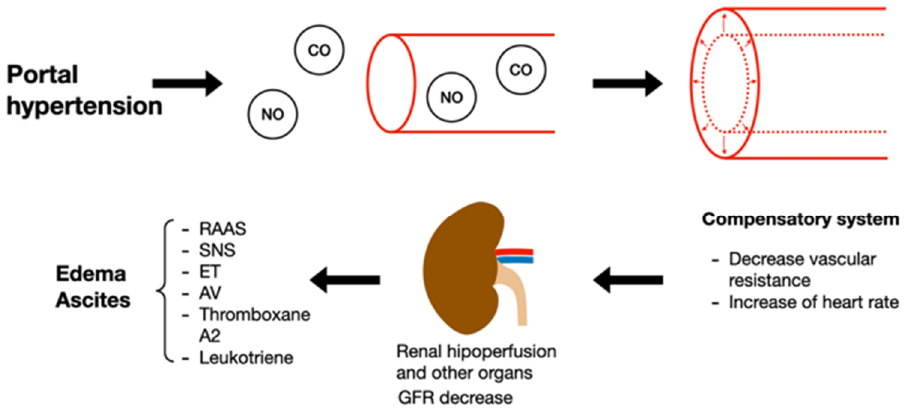
Figure 4. Pathophysiology of kidney damage induced by liver disorders. NO: nitric oxide; CO: carbon monoxide; GFR: glomerular filtration rate; RAAS: renin angiotensin aldosterone system; SNS: sympathetic nervous system; ET: endothelin; AT: arginine vasopressin.